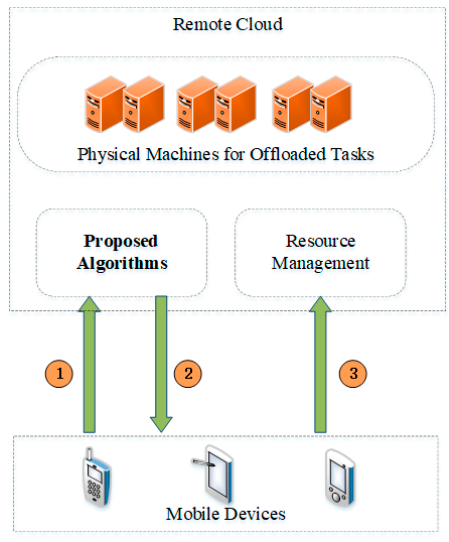
Figure 3. The process of offloading tasks to remote cloud.